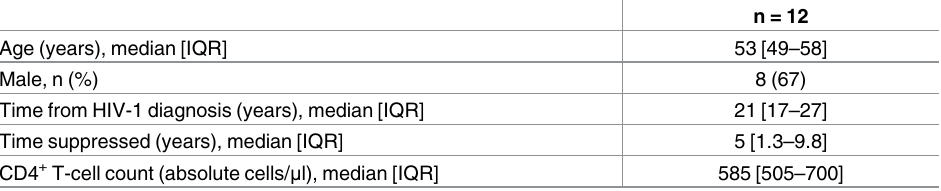
Table 2. Participants’ characteristics at